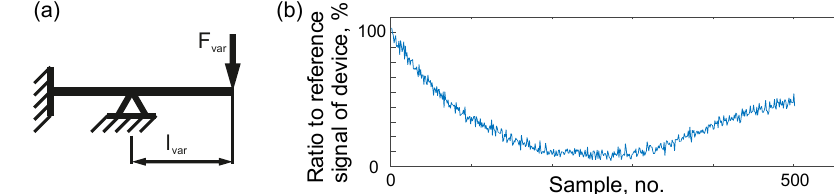
Figure 3. Conceptual configuration of different bending scenarios (a) and exemplary raw ETDR signal section used as training data (b) .